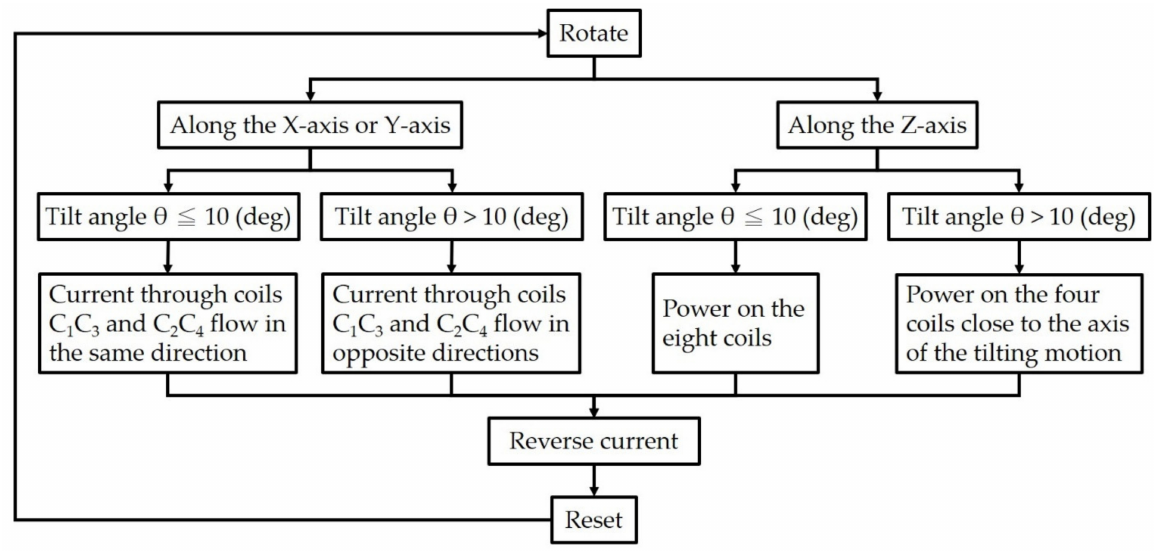
Figure 5. The flowchart to drive the proposed 3-DOF spherical